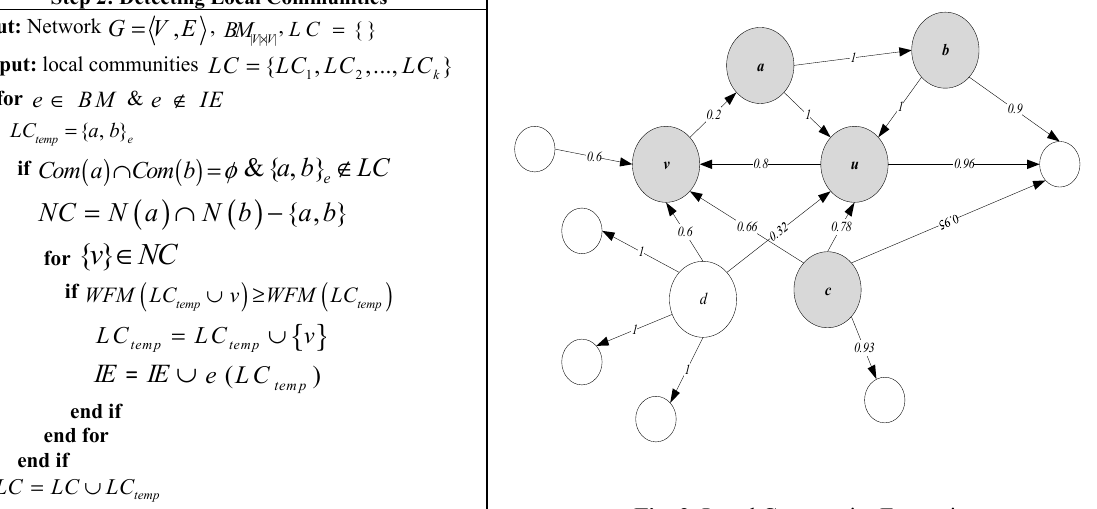
Fig. 2. Local Community